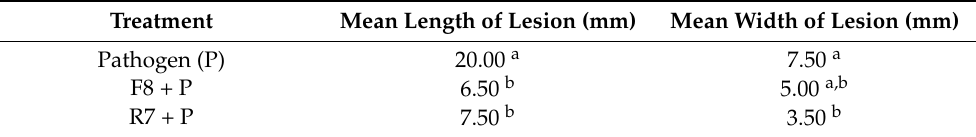
Table 4. Mean values of lesion length and width on the crown of the tomato seedlings at the 4th day of pathogen